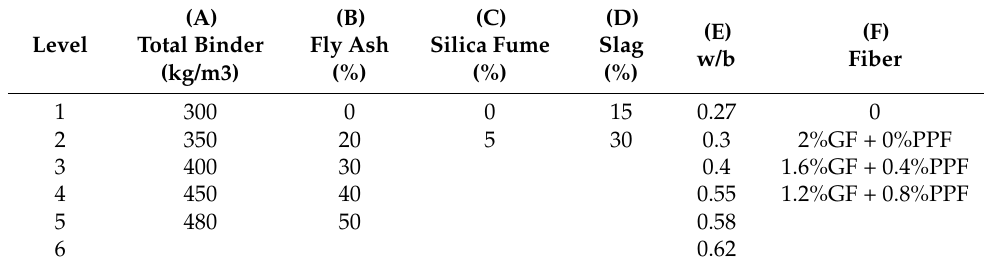
Table 7. Orthogonal factor level